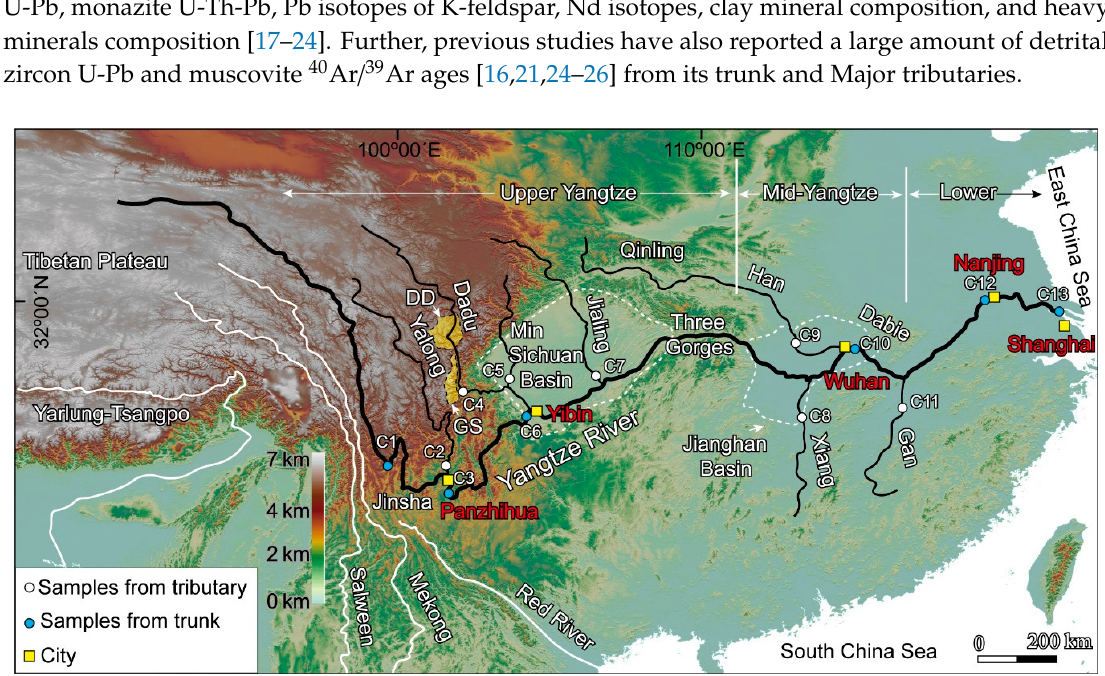
Figure 1. A schematic map showing the drainage basin, sampling locations and main distributaries of the Yangtze River. Sample locations of major tributaries are shown as open circles. Samples from the main trunk are shown as filled blue circles. The yellow shadow areas represent the Danba dome (DD) and Gongga shan (GS).